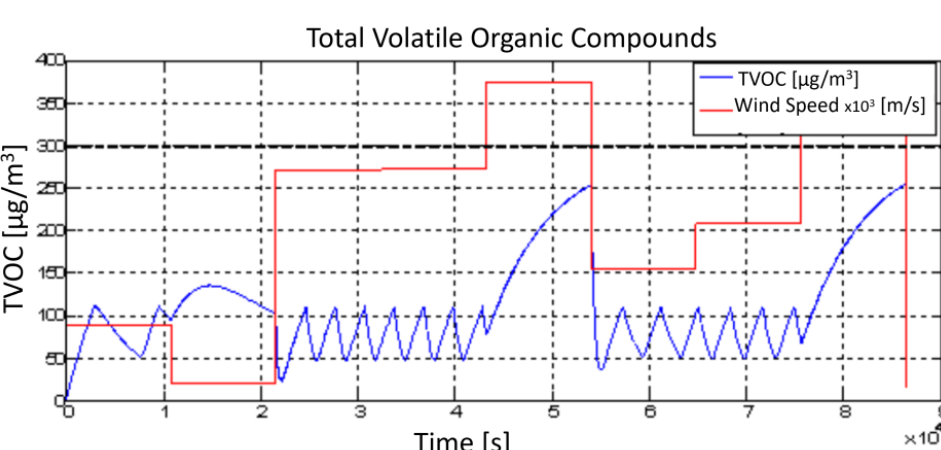
Figure 24. Control results: IAQ control, TVOC (CV).